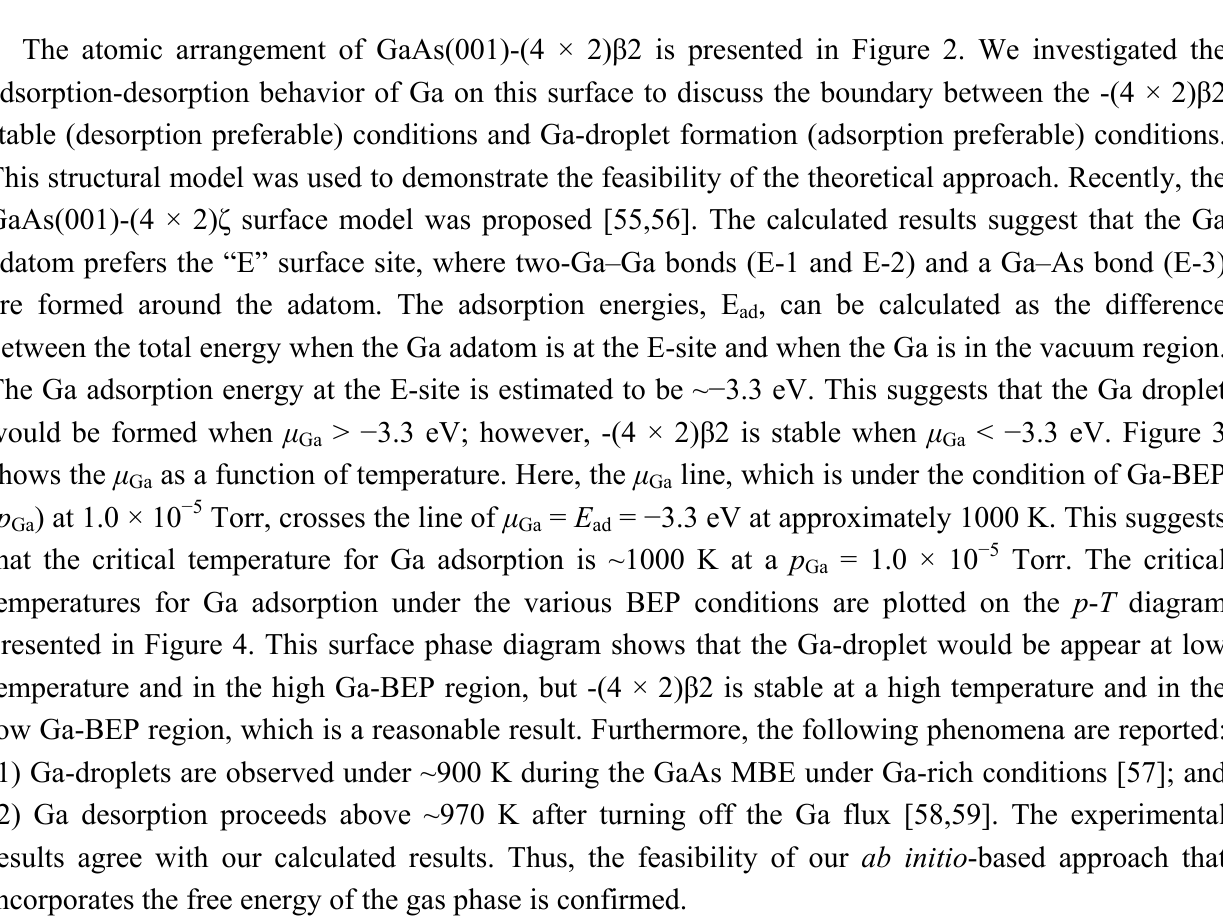
Figure 2. Schematic of the GaAs(001)-(4 × 2) β 2 surface. Adsorption sites are indicated